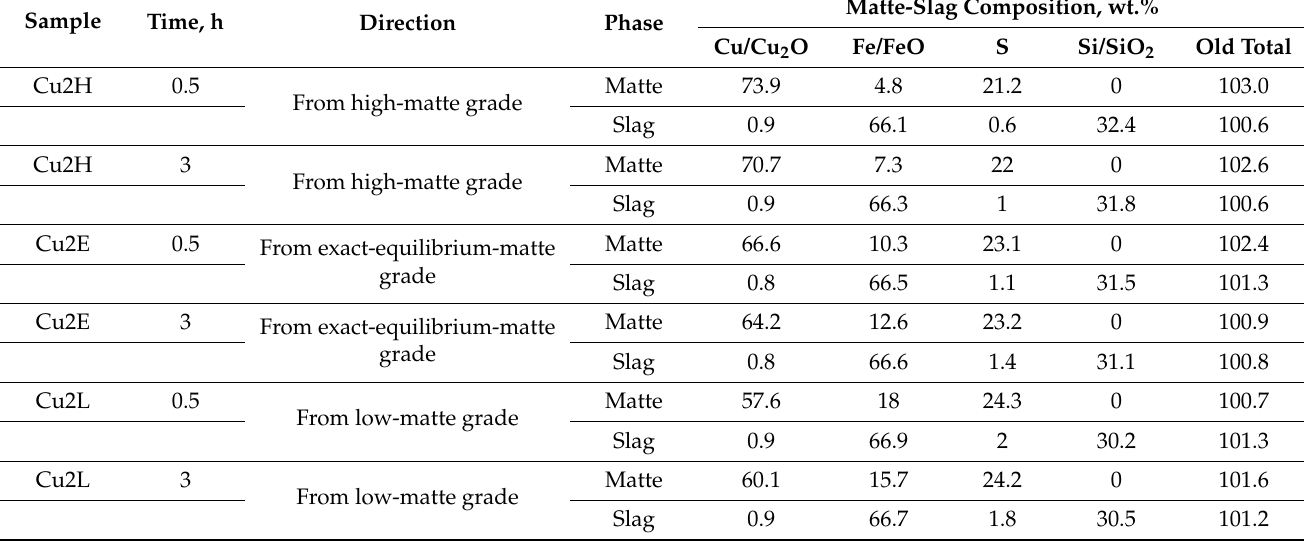
Table 4. Phase compositions for semi-open slag–matte–metal–tridymite experiments in the